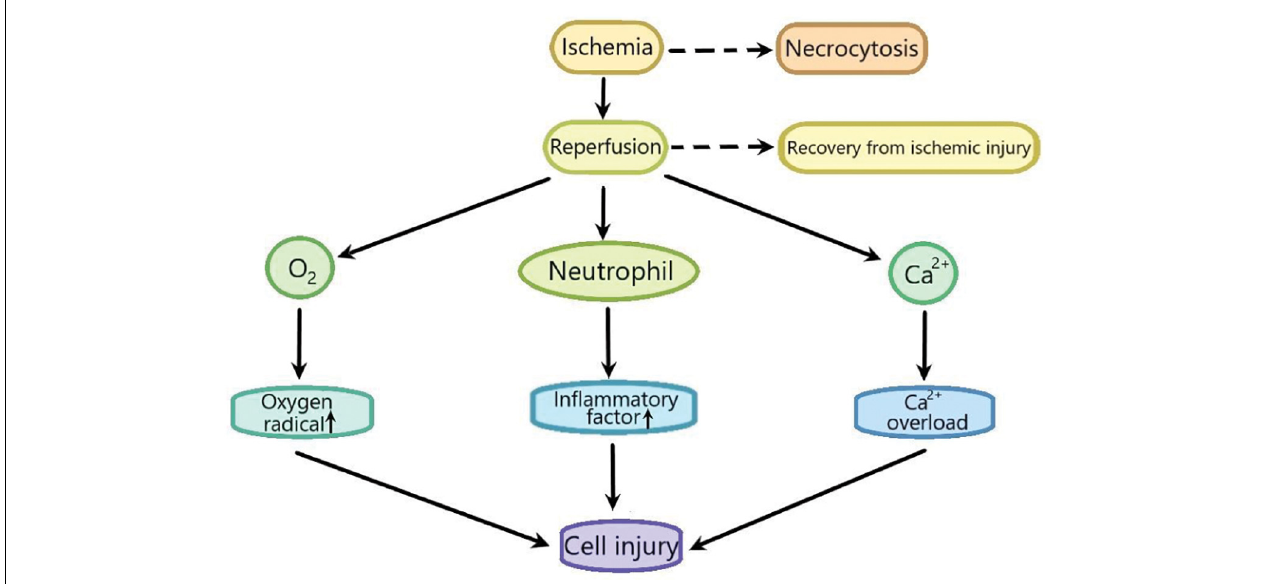
FIGURE 1 | The sketch of the process of ischemia-reperfusion injury. Ischemia leads to cell necrocytosis. Reperfusion induces a large amount of Ca 2 + influx to lead Ca 2 + overload which causes the cell injury. Reperfusion also induces the production of excessive oxygen free radicals, promotes the accumulation of pro-inflammatory factors such as neutrophils, and finally aggravates cell injury.